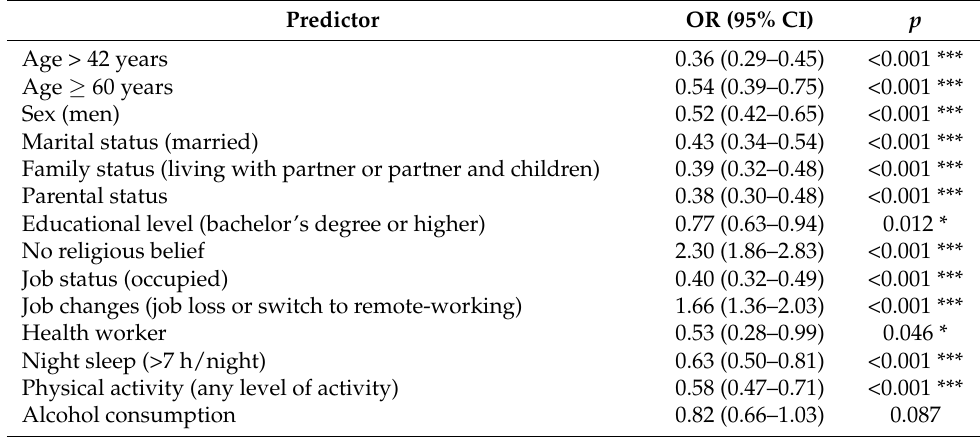
Table 4. Univariate logistic regression analysis of factors associated with depressive symptoms at PHQ-9 (total score > 10, at least 5 items ≥ 2, and item 1 or 2 ≥